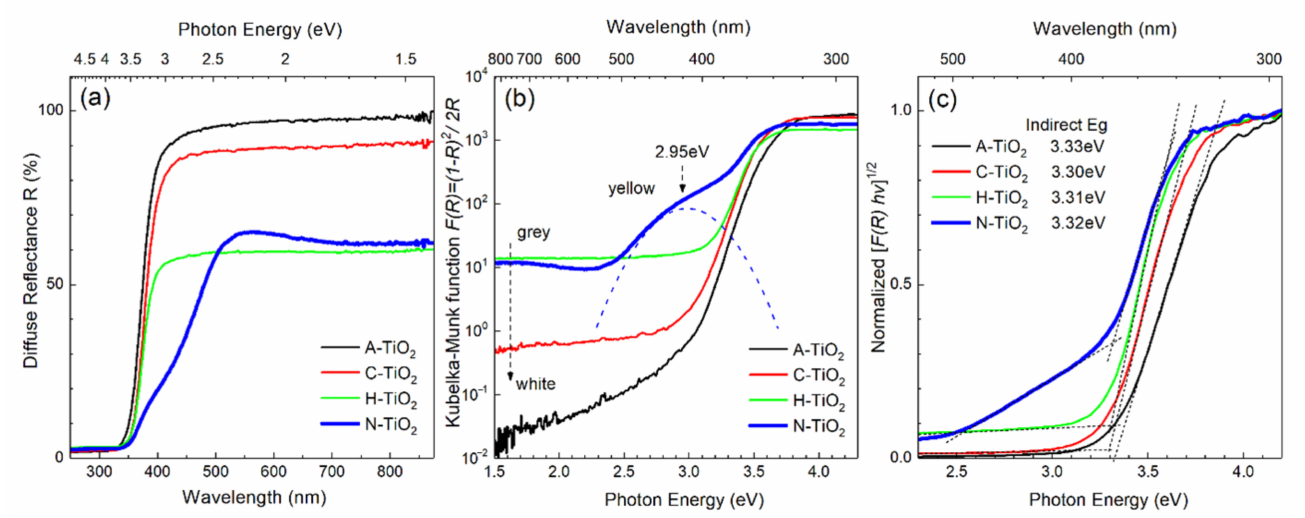
Figure 4. Optical absorption properties of the TiO 2 powders: diffuse reflectance ( a ), modified Kubelka-Munk function ( b ), Tauc plot assuming indirect (allowed) transitions ( c